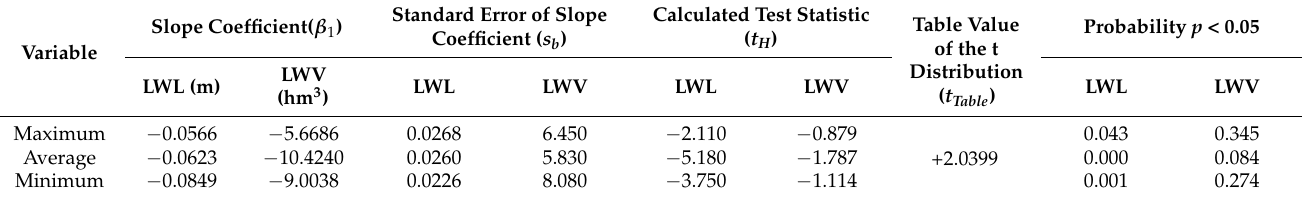
Table 4. Equation coefficient significance test of regenerated LWL and LWV